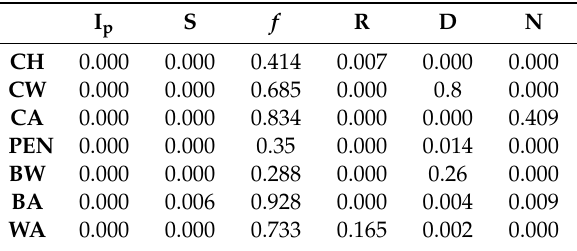
Table 4. ANOVA results (p-value) in order to understand the existing influence of the inputs on the outputs of the welds. The results indicate that f has minimum influence on the outputs of the